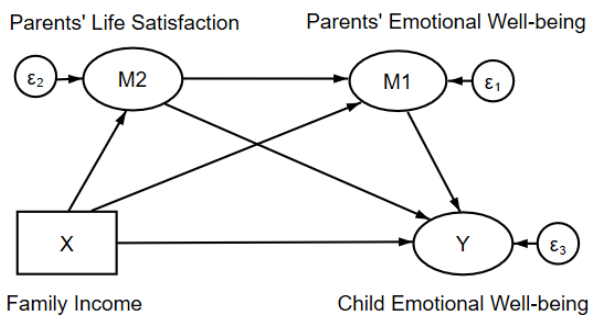
Figure 2. Conceptual model of the mediation effect of parents’ life satisfaction and emotional wellbeing.